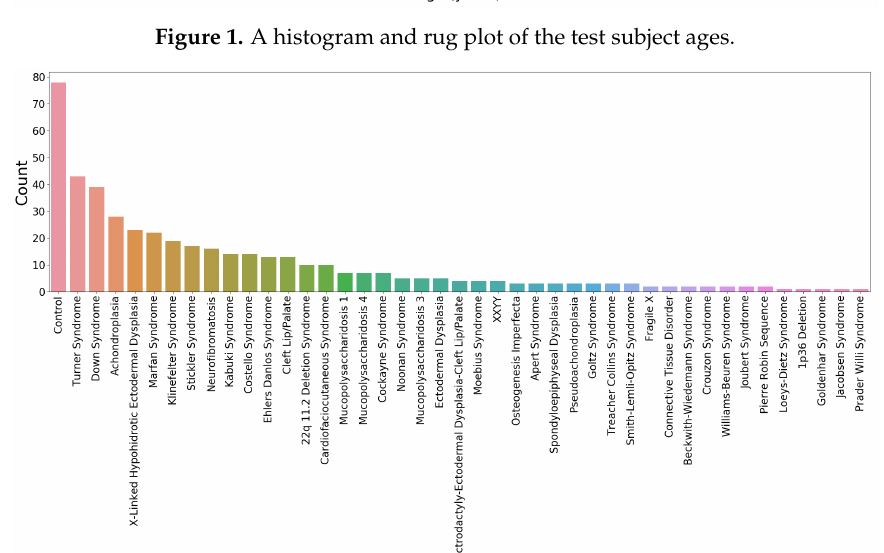
Figure 2. The syndrome distribution of the test